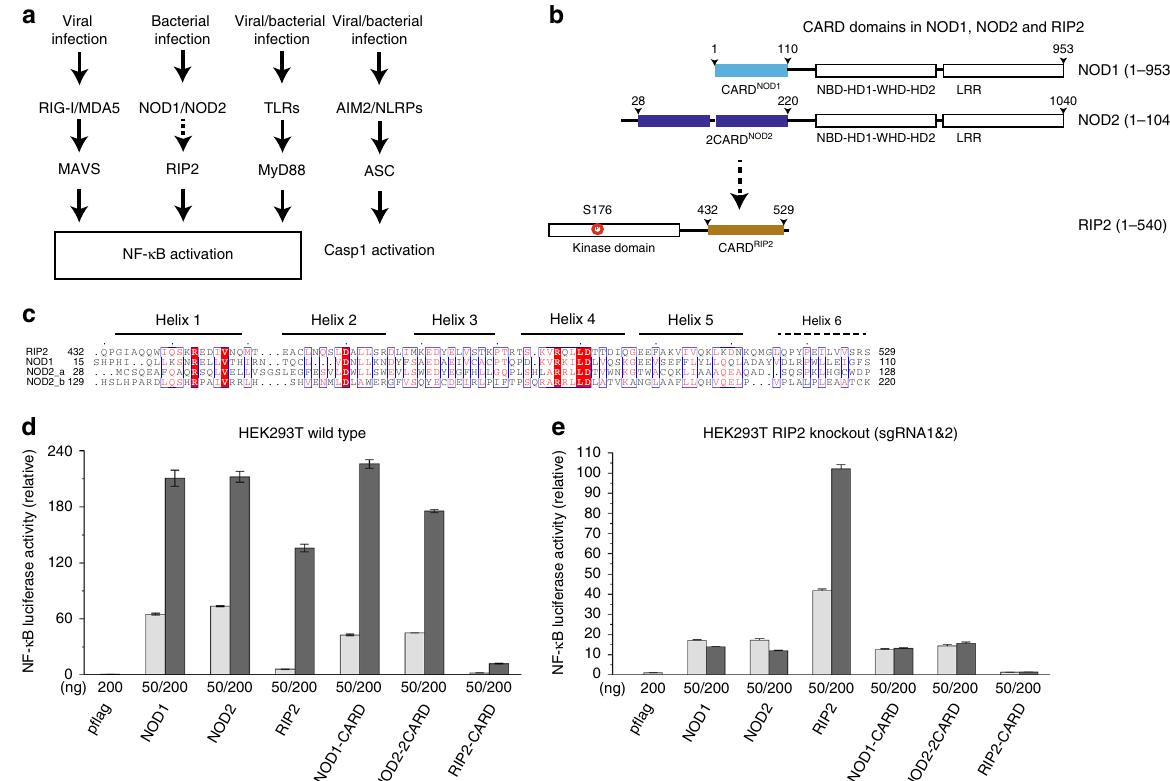
Fig. 1 CARD domains from NOD1/2 and RIP2 are important for signaling. a Schematic overview of canonical RLR – MAVS, NOD1/2 – RIP2, TLR – MyD88, and ASC signaling pathways. Adapters with CARD/pyrin domains relaying the activation signal from PRRs to their corresponding downstream effectors. The dashed arrow indicates previously proposed interactions between NOD1/2 and RIP2 via their CARD domains. b Illustrations of protein domain structure of human NOD1, NOD2, and RIP2. The CARD domains are highlighted in colors (light blue for NOD1 – CARD, blue for NOD2 – CARD, and orange for RIP2 – CARD). c Sequence alignment of RIP2 – CARD, NOD1 – CARD, NOD2 – CARDa, and NOD2 – CARDb. Conserved residues are highlighted in orange and red colors. d , e NF- κ B promoter activation by NOD1, NOD2, RIP2 proteins, and their CARD domains in HEK293T and HEK293T RIP2 KO cell lines. HEK293T cells were transfected with empty p fl ag vector or NOD1, NOD2, RIP2, RIP2 – CARD, NOD1 – CARD, and NOD2 – CARD together with pGL4.32 NF- κ B-RE vector, and CMV- Renilla vectors. The amount of plasmids that were transfected was calibrated with pFlag plasmids to ensure that the same amount of plasmids were used in each transfection. Cells were harvested 24 h post transfection and the level of NF- κ B promoter activity was measured by dual luciferase assay according to the manufacturer ’ s instructions. Error bar represents standard deviation values of three independent